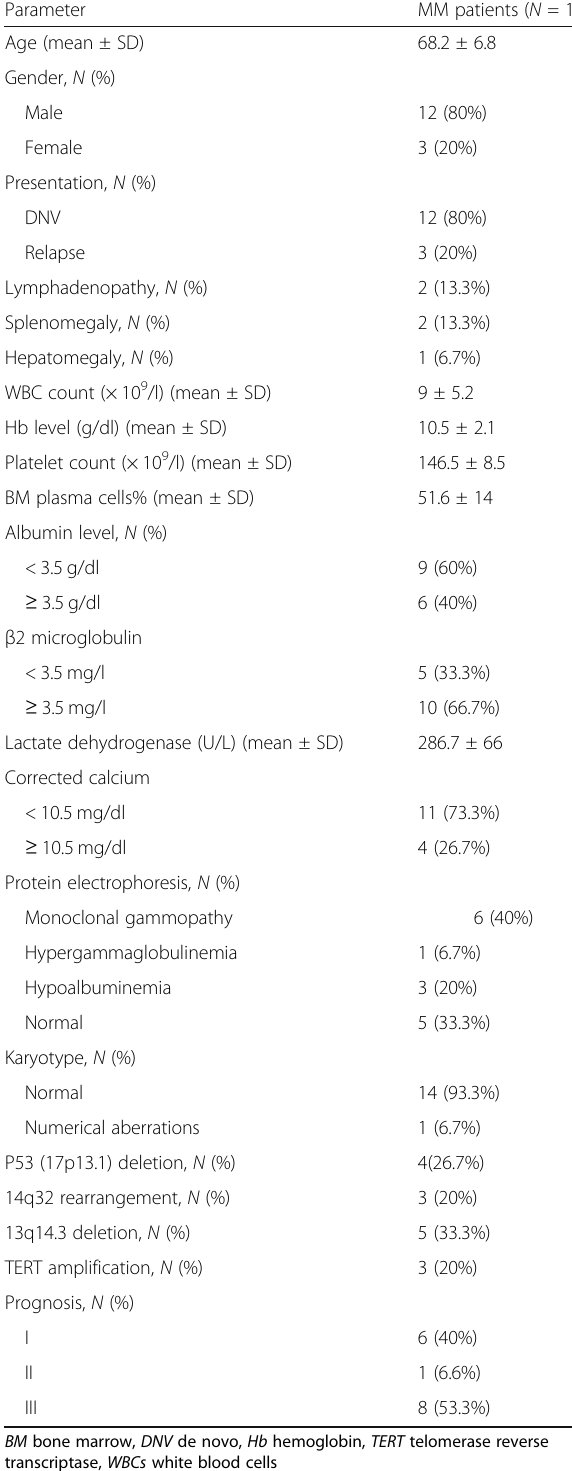
Table 1 Descriptive data of multiple myeloma patients (group